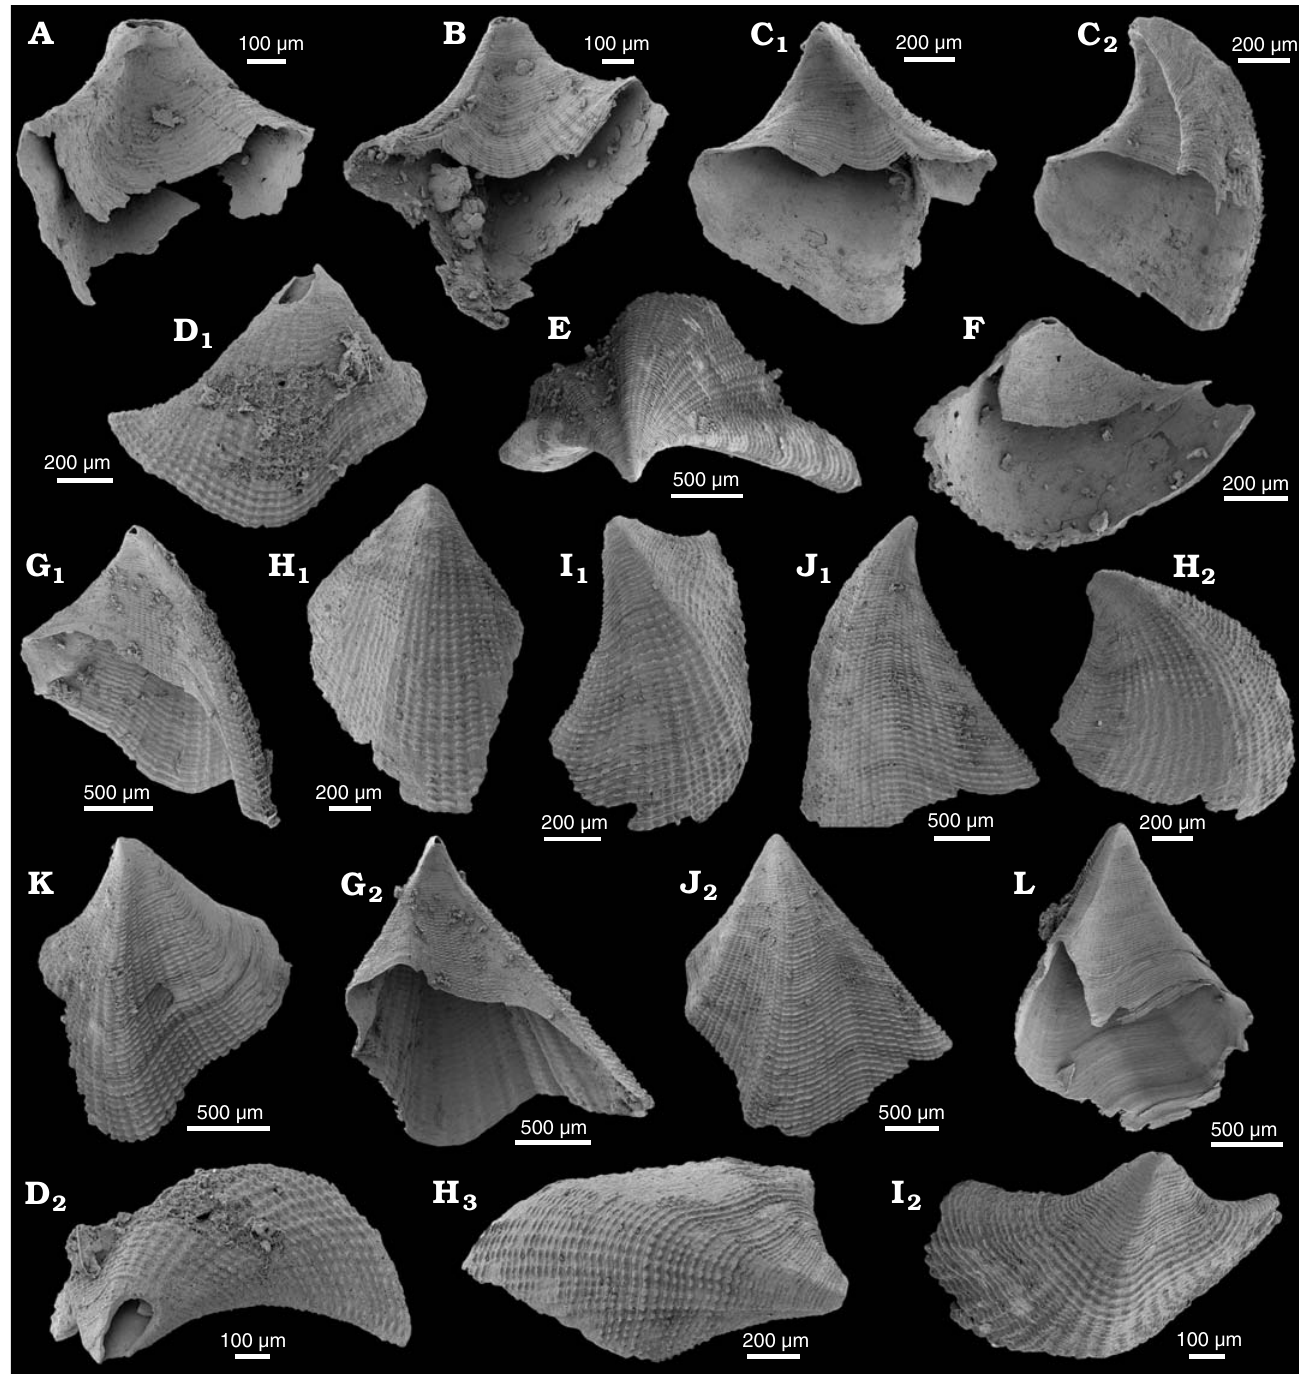
Fig. 16. C1 sclerites of the camenellan tommotiid Dailyatia decobruta Betts sp. nov. from the lower Cambrian White Point Conglomerate, Kangaroo Island, South Australia. A . SAM P57340 in ventral view. B . SAM P57341 in ventral view. C . SAM P57342 in ventral view shows shortened ventral field (C 1 ) and in oblique view (C 2 ). D . SAM P57343 in dorsal view (D 1 ); D 2 , apical view oriented to show overall convexity of sclerite. E . SAM P57344 in apical view. F . SAM P57345 in apical view. G . SAM P57346 in oblique view showing shortened ventral field (G 1 ) and in ventral view (G 2 ). H . SAM P57347 in dorsal view; H 1 –H 3 , show convex dorsal field with very weak plication. I . SAM P57348 in oblique dorsal view (I 1 ); I 2 shows convexity. J . SAM P57349 in oblique dorsal view; J 1 shows curvature of sclerite in side view; J 2 shows dorsal surface. K . SAM P57350 in dorsal view. L . SAM P57351 in oblique ventral Diagnosis . — Species of Dailyatia with strong ornament of raised pustules, often aligned to form strong pseudoplicae.